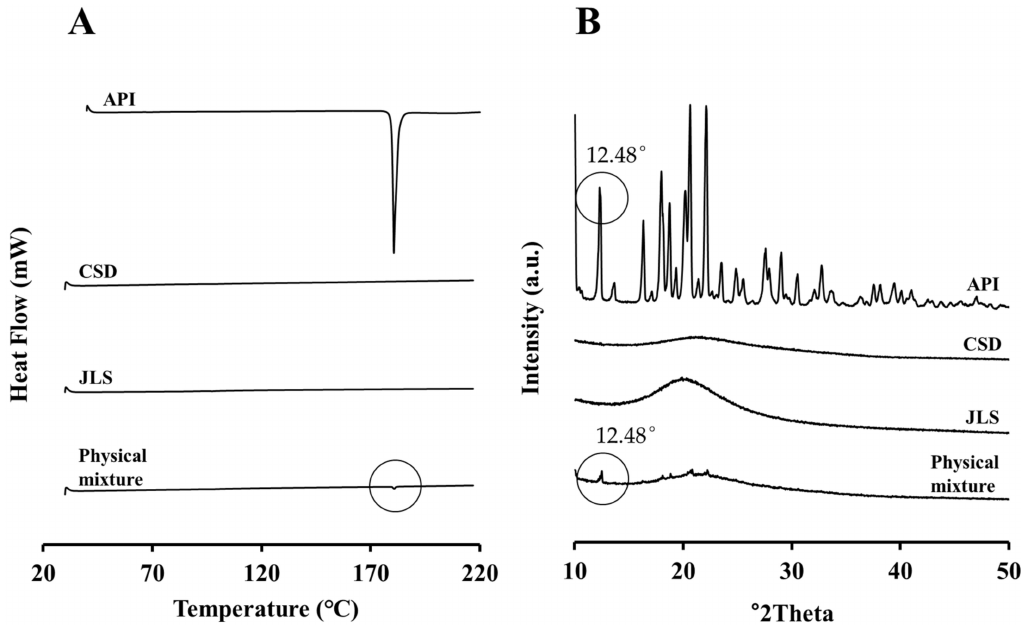
Figure 5. Physicochemical properties of the interaction between JIN-001 and JLS. ( A ) DSC analysis; ( B ) Powder X-ray diffraction (PXRD)